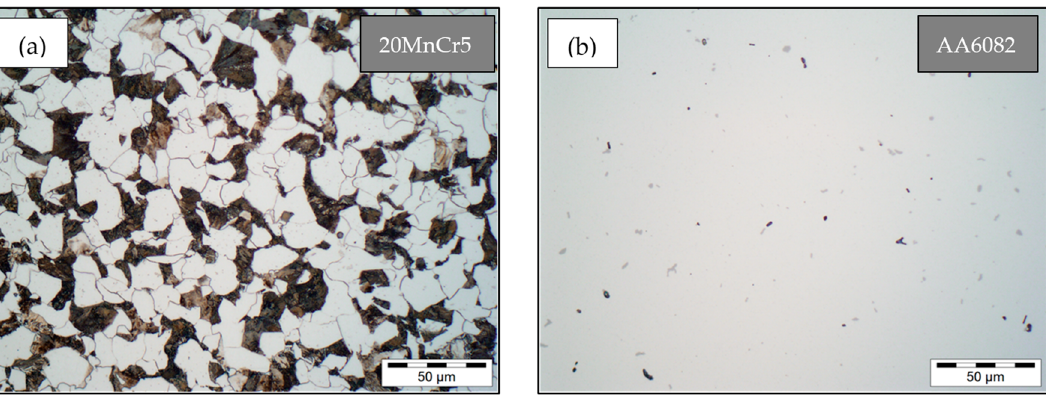
Figure 2. ( a ) Ferritic–pearlitic microstructure of the 20MnCr5 steel in the soft annealed condition, etched with Nital (3%), and ( b ) unetched micrograph of the AA6082 aluminum alloy (T6 condition).